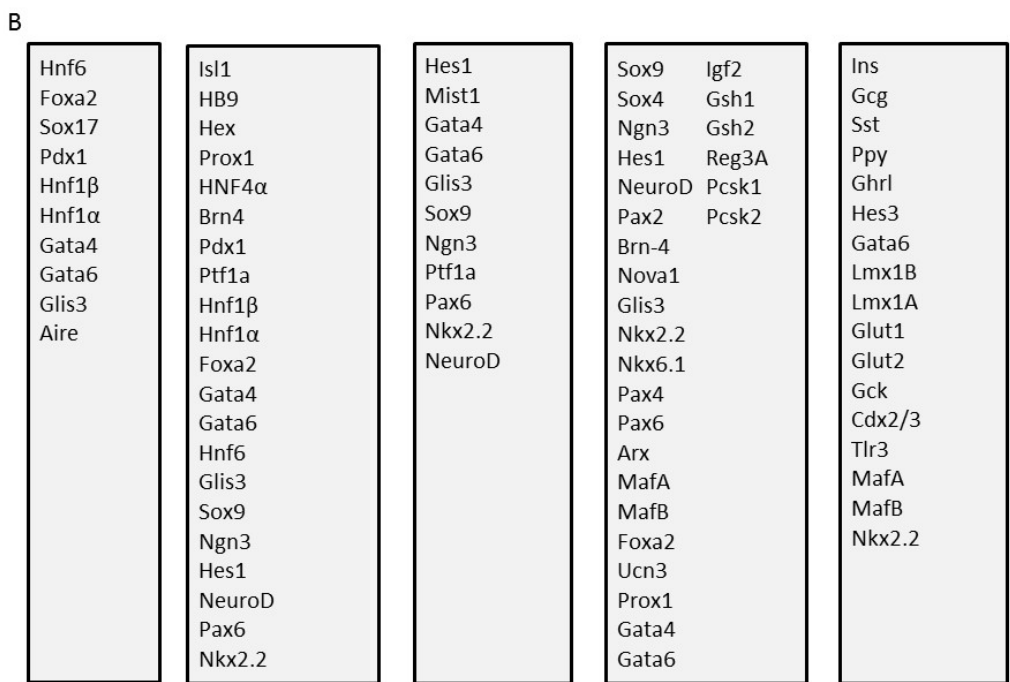
Figure 1. ( A ) Diagram of the major morphogenic events during islet development. ( B ) A cascade of different transcription factors, hormones and cell specific markers are expressed within different stages of pancreatic development that are responsible for the morphogenic events leading to islet formation and cellular differentiation. The diagram was inspired by [6,13]. DP, Dorsal pancreatic bud; VP, Ventral pancreatic bud; GB, Gall bladder; dpc, days post conception; CS, Cambridge stage.